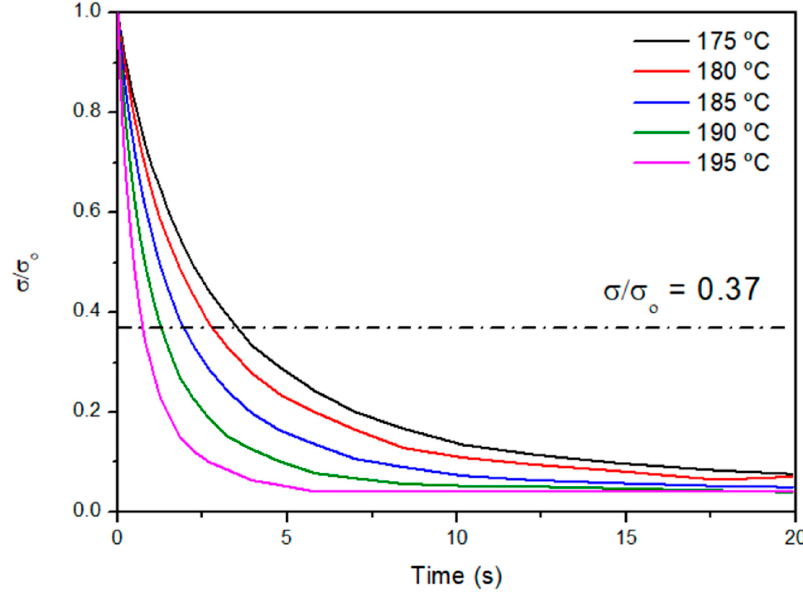
Figure 6. Normalized stress relaxation plots as a function of time at various temperatures from 175 to 195 °C for the sample SQLM 2575 catalyzed by DBTDL.